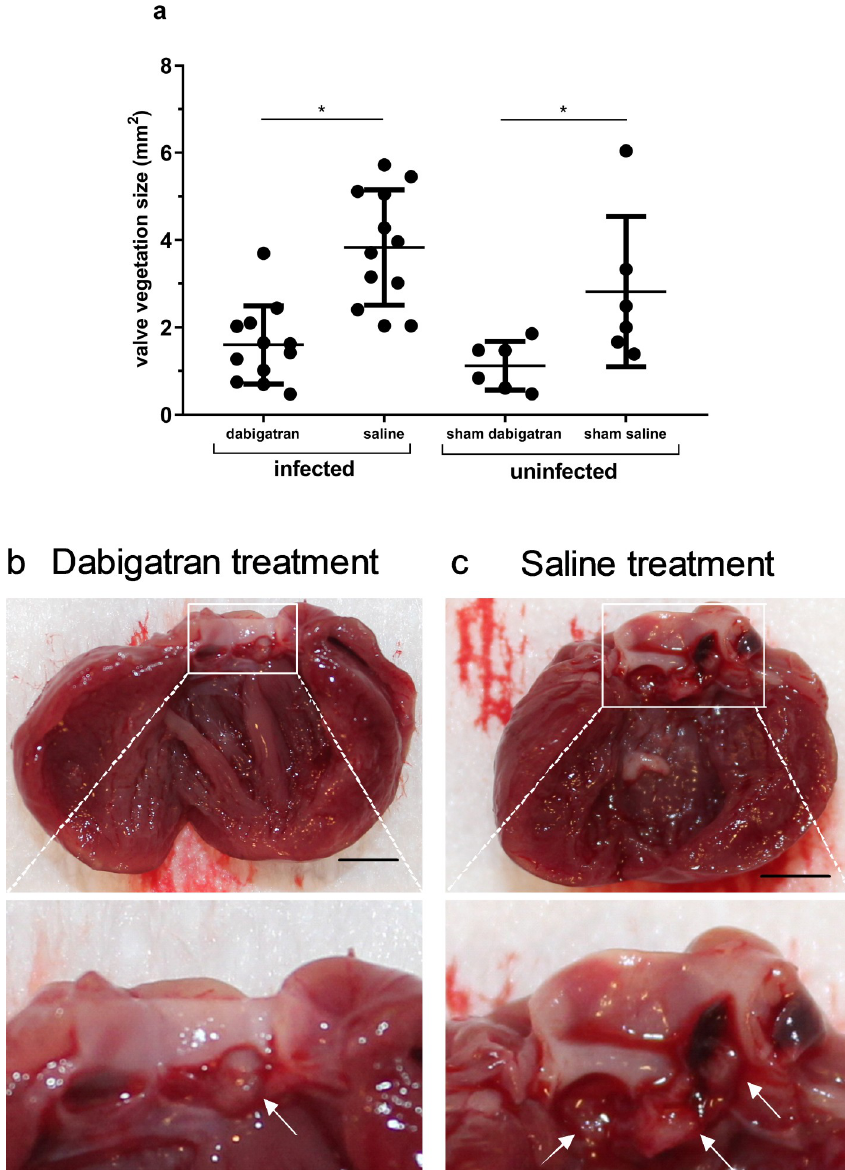
Fig 2. Dabigatran effect on valve vegetation size. A significant reduction in valve vegetation size was seen for dabigatran treated (10 mg/kg/b.i.d) compared to saline treated rats with S . aureus infective endocarditis (infected) evaluated 3 days post inoculation ( Fig 2A ). Both infected groups received gentamicin 20 mg/kg/day (s.c.). A significant reduction of the valve vegetation size was seen in sham control (uninfected) with sterile thrombotic endocarditis in the dabigatran treated (10 mg/kg/b.i.d) group compared to saline controls evaluated 3 days post removal of catheter ( Fig 2A ). Representative macroscopic images of valve vegetations from one rat treated by dabigatran ( Fig 2A ) and saline ( Fig 2C ), arrows indicating the valve vegetations located at the aortic leaflets. Black scale bar indicates 3 mm. Horizontal lines represent means ± standard derivation. � indicate p < 0.05 by unpaired t-test.